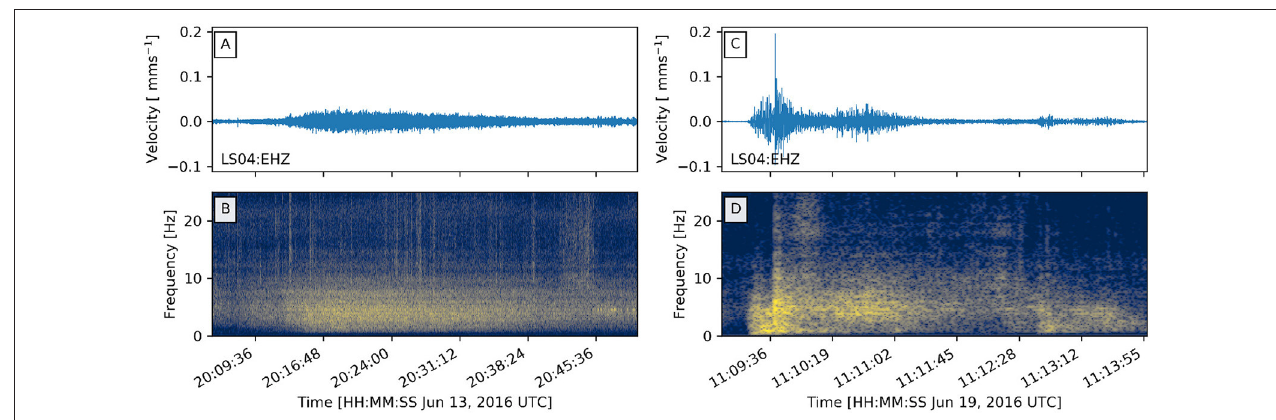
FIGURE 8 | Example seismic records (A,C) and frequency spectrograms (B,D) of a lahar on 13th June 2016 (A,B) and an explosion followed by a pyroclastic density current on 19th June 2016 (C,D) . The unfiltered seismic waveforms were recorded at station LS04. The waveform and frequency characteristics shown here are typical for these types of events as recorded at this station. Spectral scale is identical to that in Figure 5 .